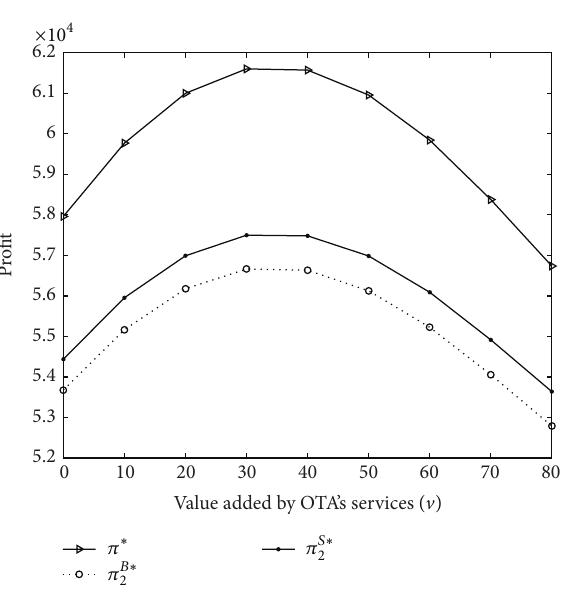
Figure 5: The profit